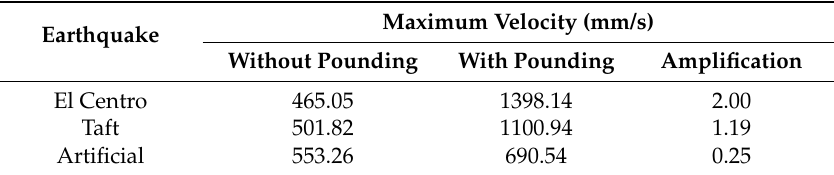
Table 7. Maximum velocity values for model B.